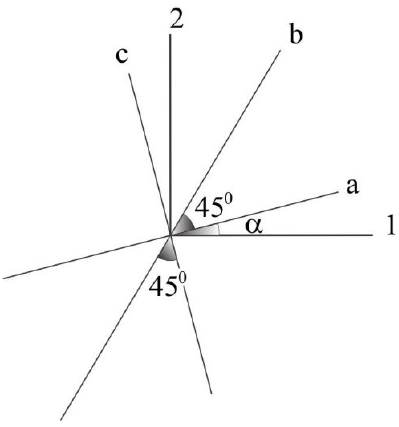
Figure 5. Main axis system position, where: 1,2 are cartesian reference system axis and a,b,c are axis of gauge tensometric rosette.